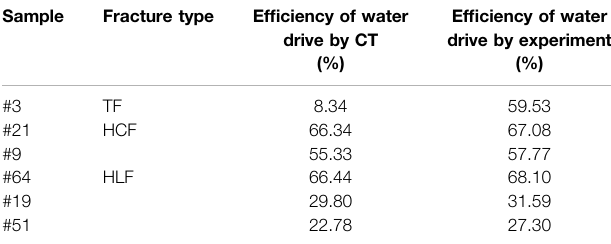
TABLE 7 | Statistics on the ef fi ciency of water drive calculated by CT or